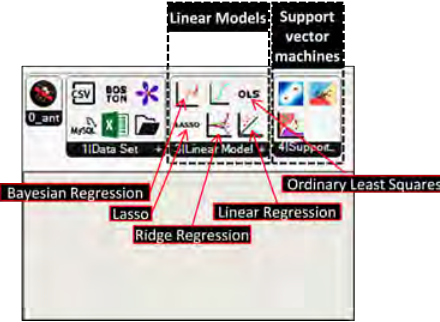
Figure 4. Machine learning categories based on their